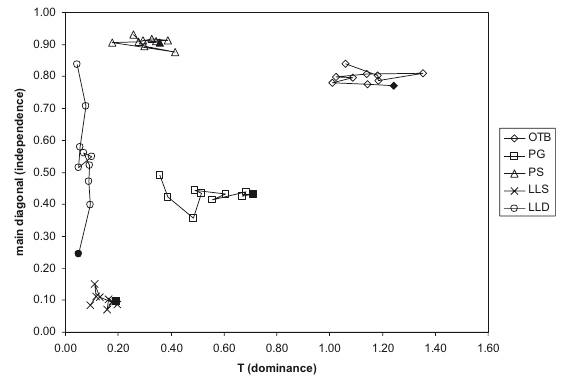
F ig . 3. – Independence vs dominance plot of five fleets in Catalonia, showing the annual trends. The first year of the series (2000) is in- dicated by a solid